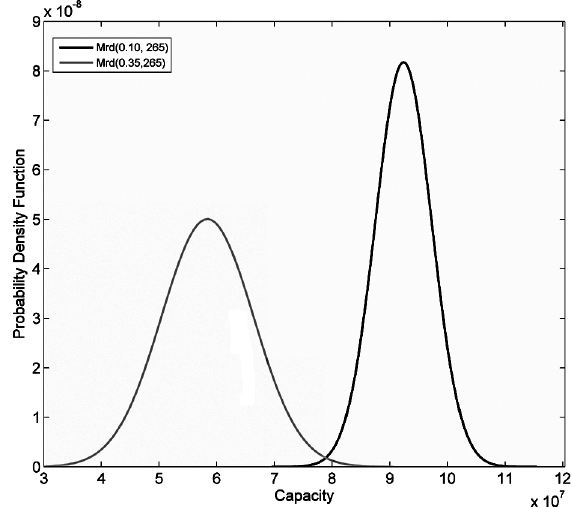
Fig. 9. Two plots of the time-dependant PDF of the capacity for a mean steel strength f y = 235 N/mm of 10% (grey line) and 35% (black